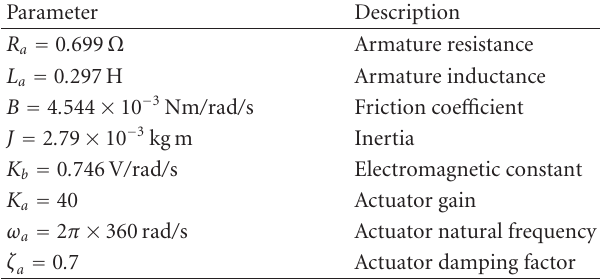
Table 1: DC motor parameters.